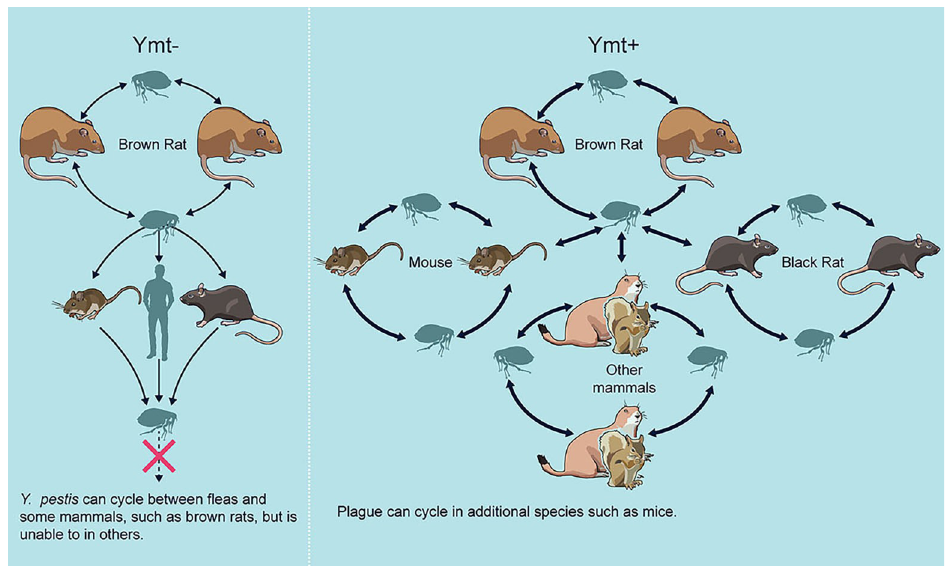
Fig 6. Model of the adaptive function of Yersinia murine toxin (Ymt) during the evolution of the flea-borne life cycle of Y . pestis . In this model, ancestral Y . pestis strains lacking the ymt gene (Ymt − ; left) could cycle between fleas and certain species of rodent with flea-colonization-permissive host blood, such as brown rats ( Rattus norvegicus ), but not those with non-permissive blood, such as mice ( Mus spp). Following acquisition of ymt on the pMT1 plasmid (Ymt+ strains; right), the progenitor of modern, extant strains of Y . pestis was able to stably colonize fleas that fed on bacteremic hosts with a blood chemistry that is not permissive for Ymt-negative strains. Thus, acquisition of